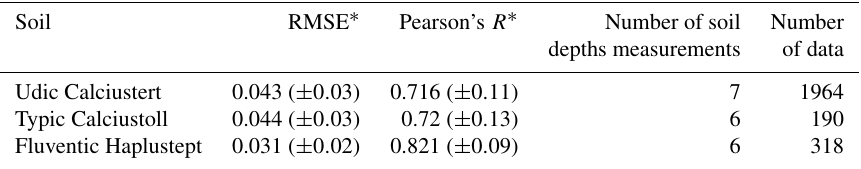
Table 2. Main performance indexes of SWAP application in the three soils (Udic Calciustert, Fluventic Haplustept and Typic Calciustoll) under maize cultivation (data from the Nitrati Campania regional project; Regione Campania, 2008). Soil RMSE ∗ Pearson’s R ∗ Number of soil Number depths measurements of data Udic Calciustert 0.043 ( ± 0 . 03) 0.716 ( ± 0 . 11) 1964 Typic Calciustoll 0.044 ( ± 0 . 03) 0.72 ( ± 0 . 13) Fluventic Haplustept 0.031 ( ± 0 . 02) 0.821 ( ± 0 . 09) 318 ∗ Average value ± standard deviation.